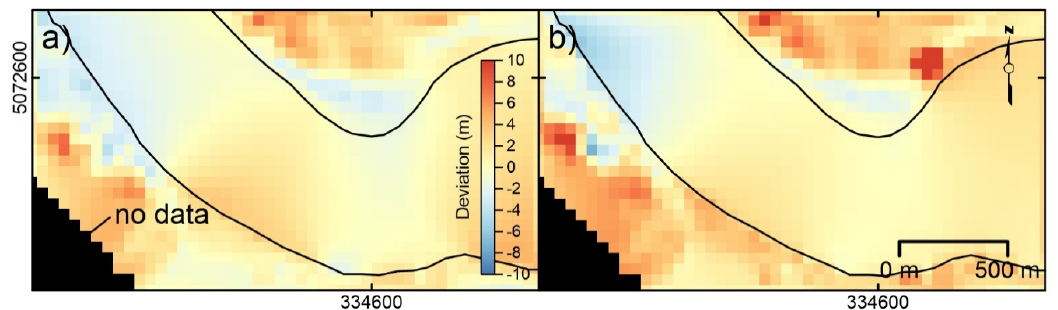
Figure 9. Miage debris-covered glacier and surrounding slopes. ( a ) Distribution of deviation in displacement along the X -axis. ( b ) Distribution of deviation in displacement along the Y -axis. UTM coordinates are shown at figure edges. Black lines indicate moving area boundary.